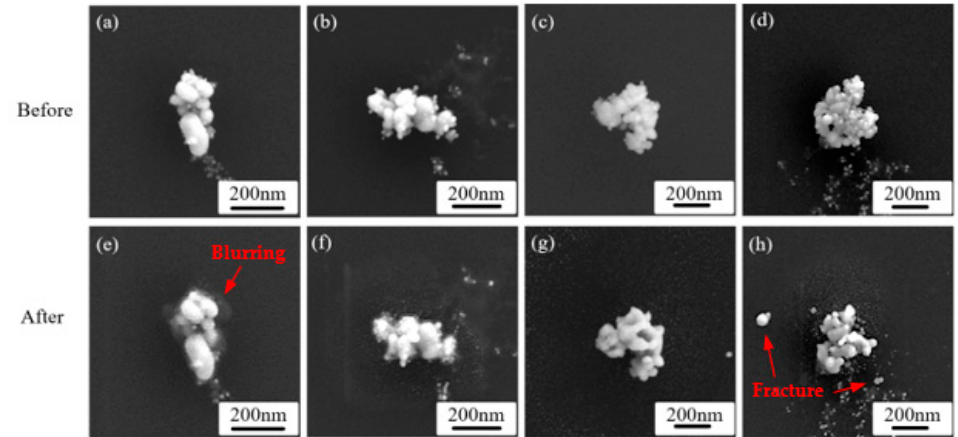
Figure 2. SEM images of Ag nano-solder before and after femtosecond laser irradiation with dif- fierent fluence: ( a , e ): 29.25 mJ/cm 2 ; ( b , f ): 42.25 mJ/cm 2 ; ( c , g ): 55.25 mJ/cm 2 ; ( d , h ): 68.25 mJ/cm 2 .